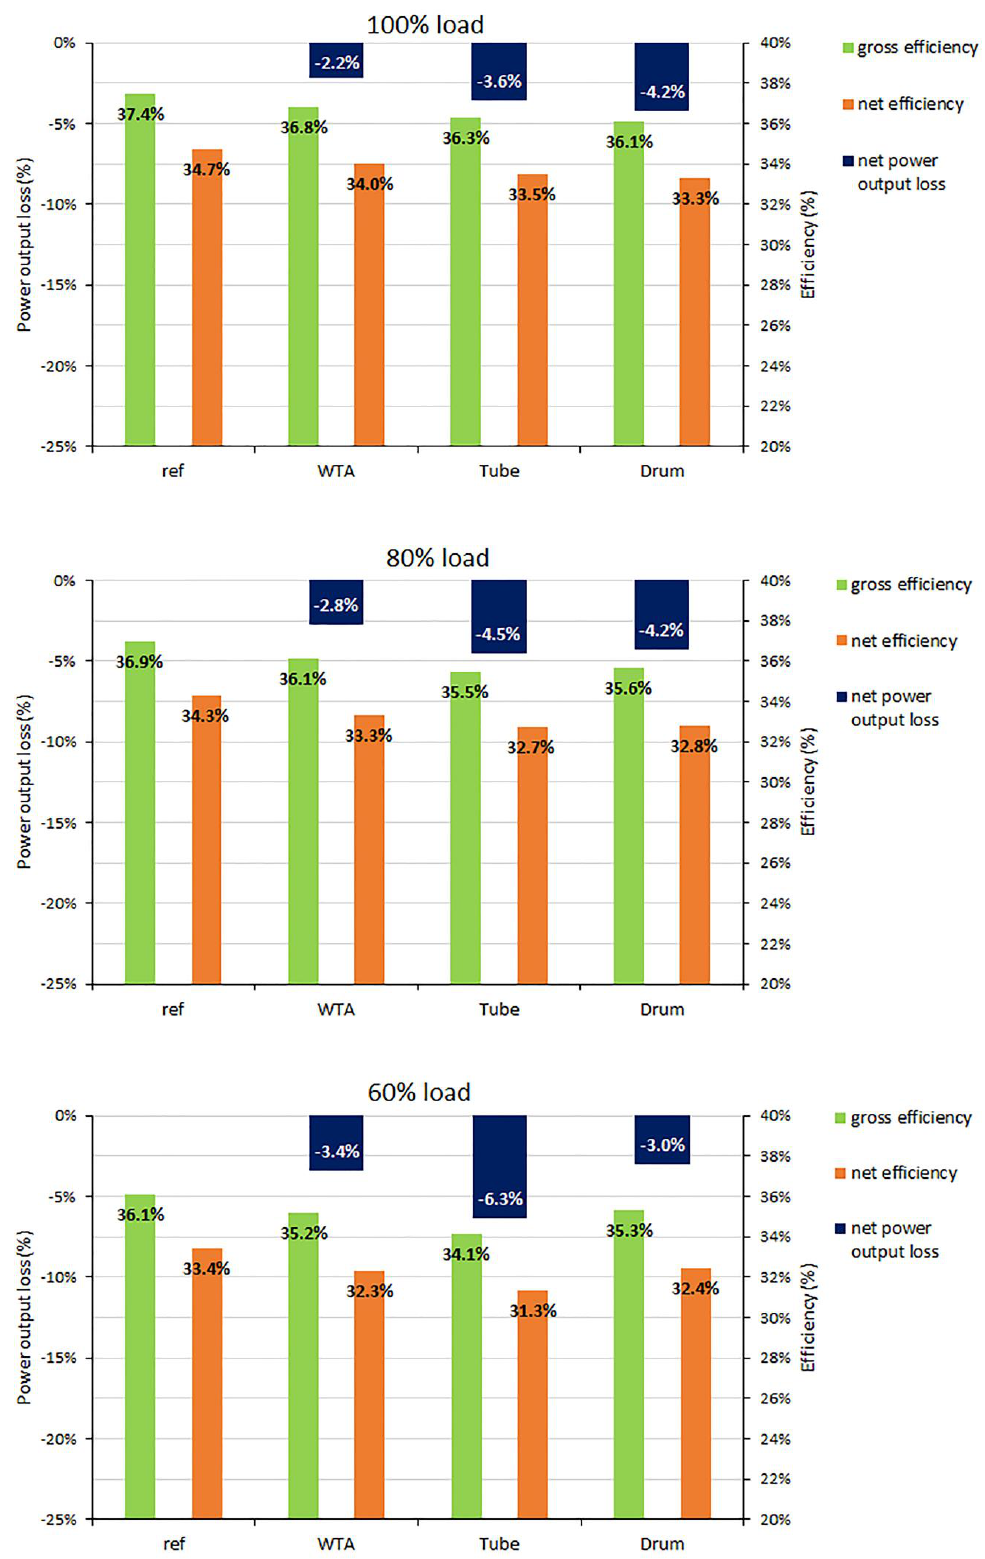
Figure 11. Comparative graphs for three loads with all three drying technologies (ref: reference, (Wirbelschichttrocknung mit interner Abwärmenutzung) WTA: fluidized-bed dryer with internal waste-heat use (WTA dryer), Tube: tube dryer, Drum: drum dryer); Reprint with permission [83]; 2019, American Society of Civil